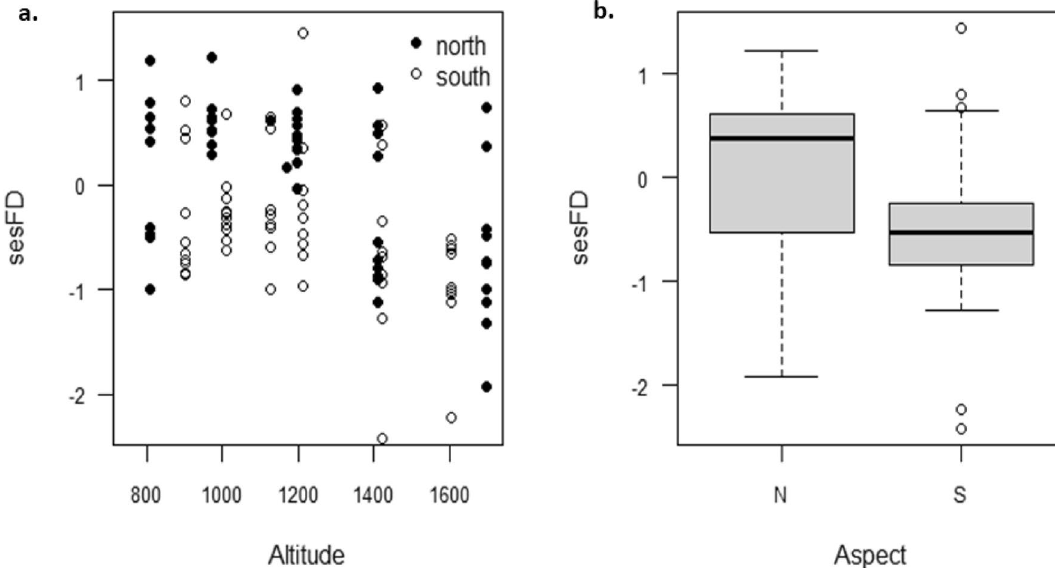
Figure 3. The relationship between sesFD and ( a ) altitude (not significant) and ( b ) aspect (significantly lower on the southern aspect, p <